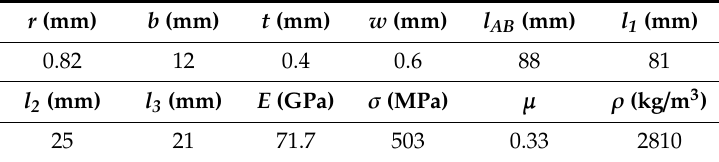
Figure 9. Finite-element model of the vibration-assisted polishing device (VPD). Table 1. Main parameters of the VPD.